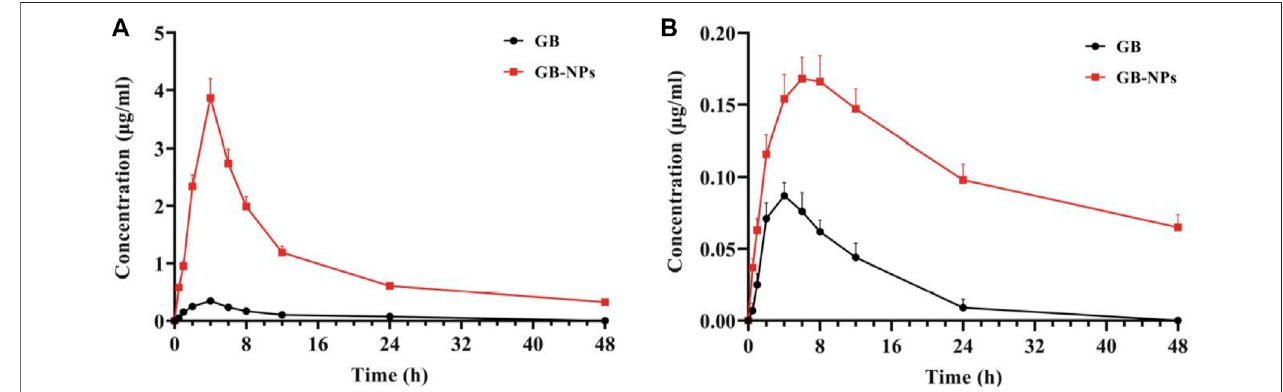
FIGURE 6 | Plasma and brain pharmacokinetic pro fi les of GB and GB-NPs in rats. (A) Plasma concentration – time pro fi le ( n = 6). (B) Brain concentration – time pro fi le ( n = 4). Reproduced from open-access Journal under the term of Creative Commons Attribution (Zhao et al., 2020). GB, ginkgolide B; NPs, nanoparticles.